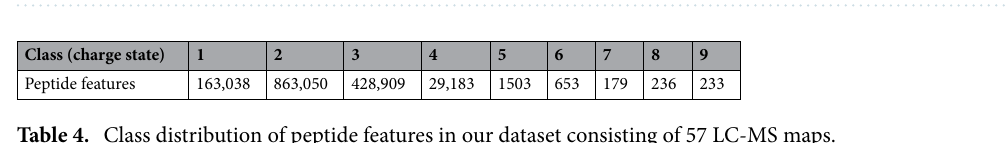
Table 4. Class distribution of peptide features in our dataset consisting of 57 LC-MS maps.